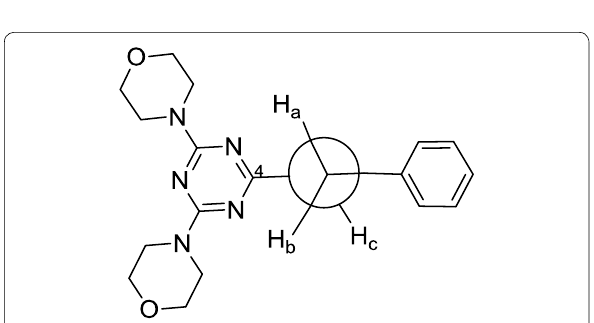
Fig. 2 Newman projection formula of N ‑(4‑benzylamino‑6‑mor‑ pholino‑1,3,5‑triazin‑2‑yl) aminobenzoic acid